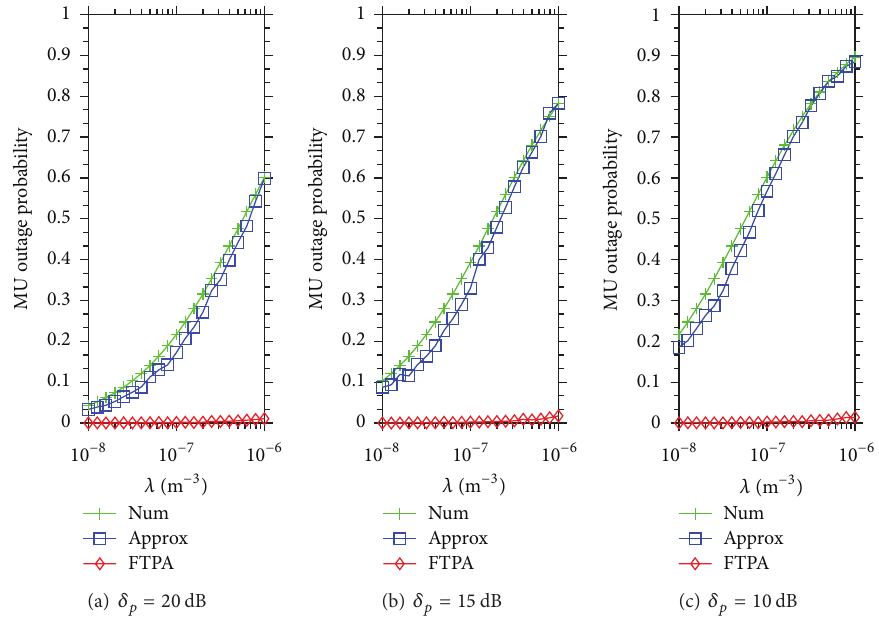
Figure 2: MU outage probability caused by Approx and FTPA versus the density of FBSs development when the QoS type of each MU is voice ( 𝜓 1 𝑚 = 5.31 dB).